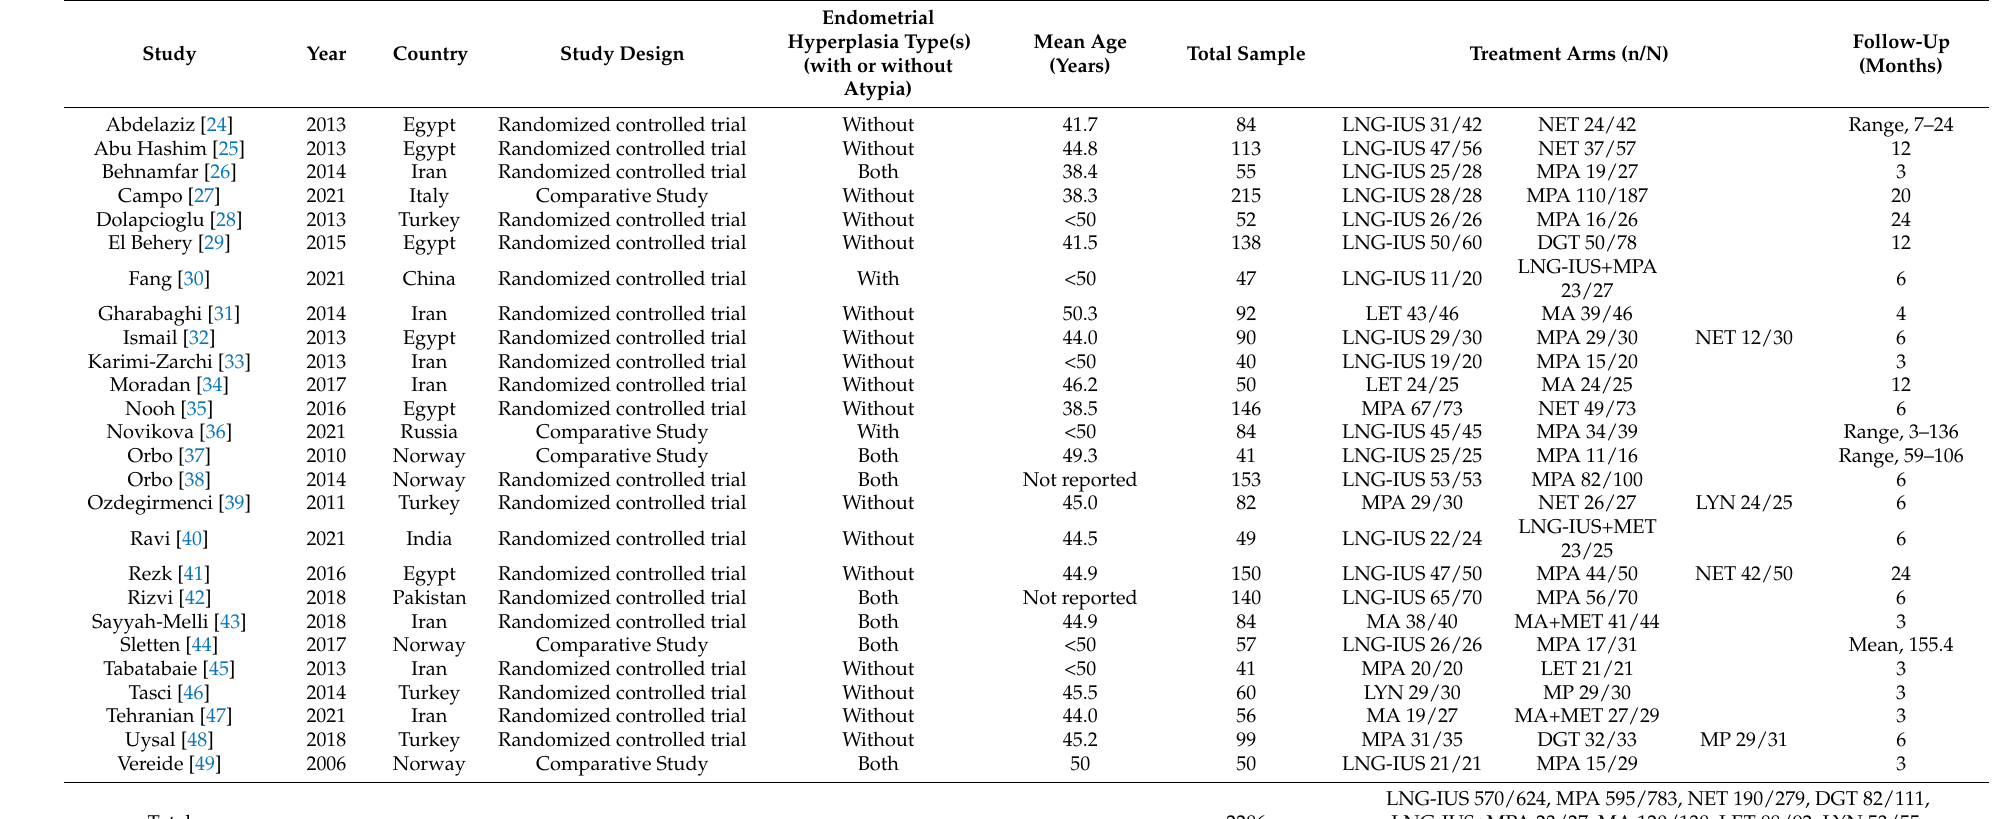
Table 1. Characteristics of included studies of patients with endometrial